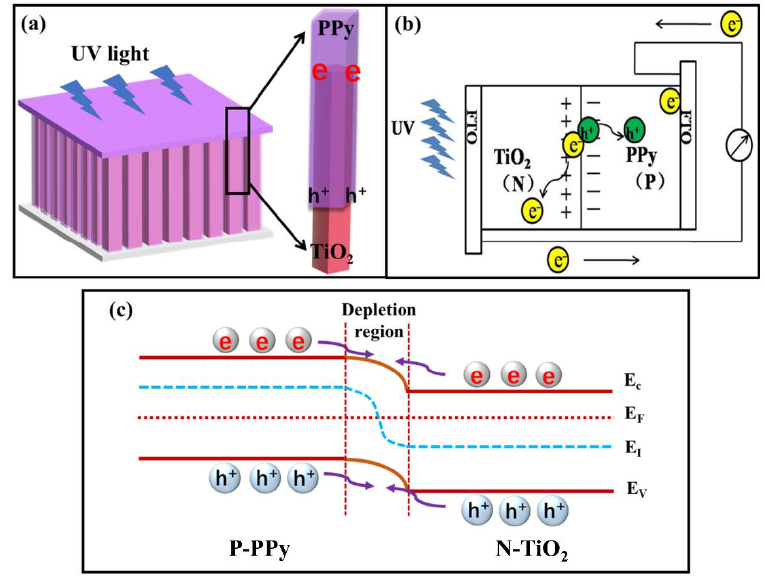
Figure 8. Schematic diagram of photoelectric response ( a , b ) and the formation mechanism of the built-in electric field of the p-n junction in PPy-TiO 2 composites ( c